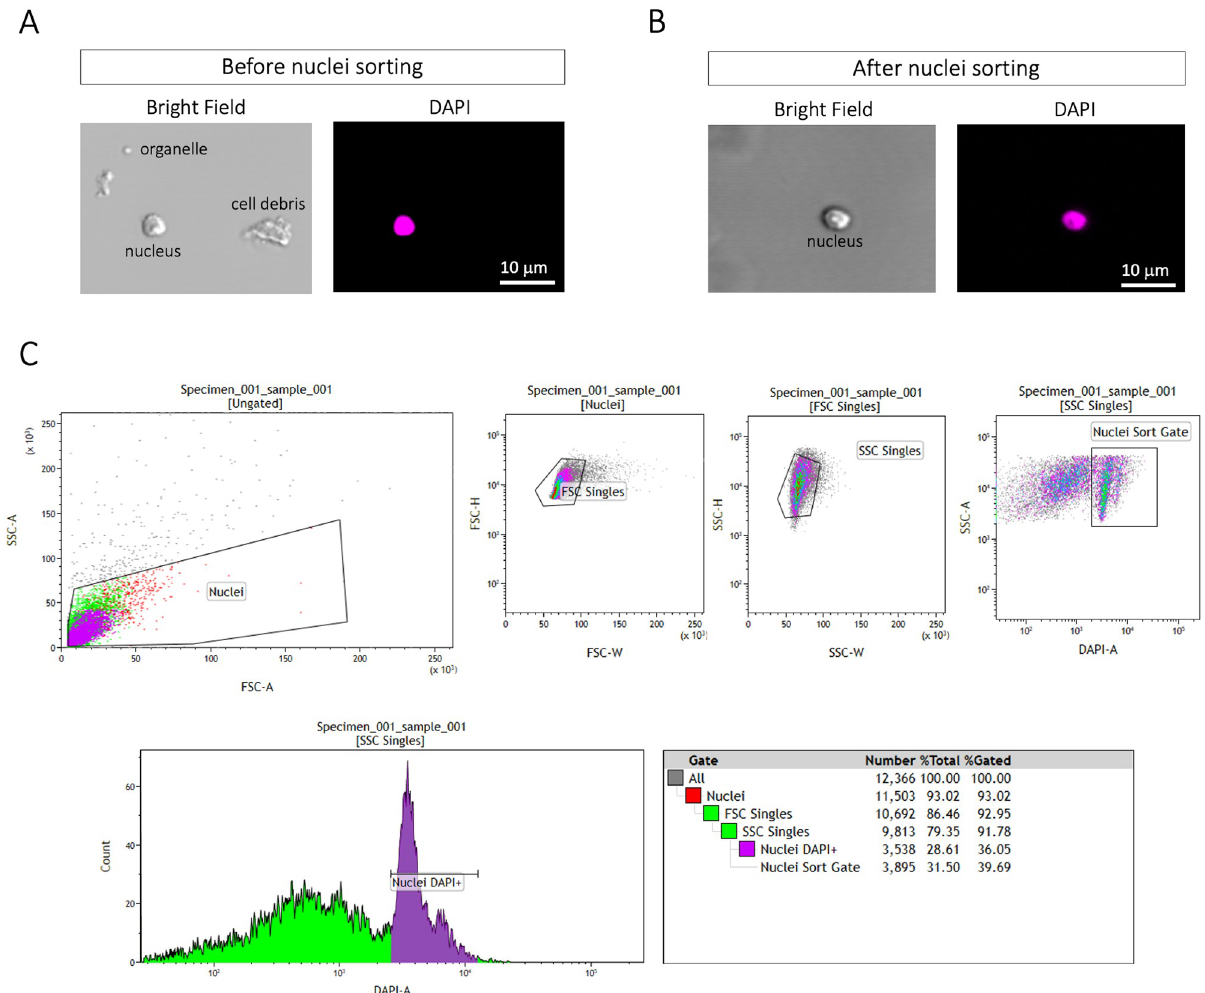
Fig 2. Fluorescence Activated Nuclei Sorting. (A, B) To minimize the contamination of organelles such as chloroplast and remove the debris that could clog the 10 × Genomics microfluidic chips, we sort the nuclei using FANS technology using a BD FACSAria ™ IIU/III upgraded cell sorter. (C) An initial gate was drawn on a FSC and SSC plot to eliminate the majority of non-nuclear debris and organelles. The final histogram was used to isolate the desired nuclei. 40,000 DAPI+ nuclei were sorted with a total recovery volume of 67–70 μ l, into a 1.5 ml RNase free non-stick Eppendorf low binding tube containing 10 μ l of NIB